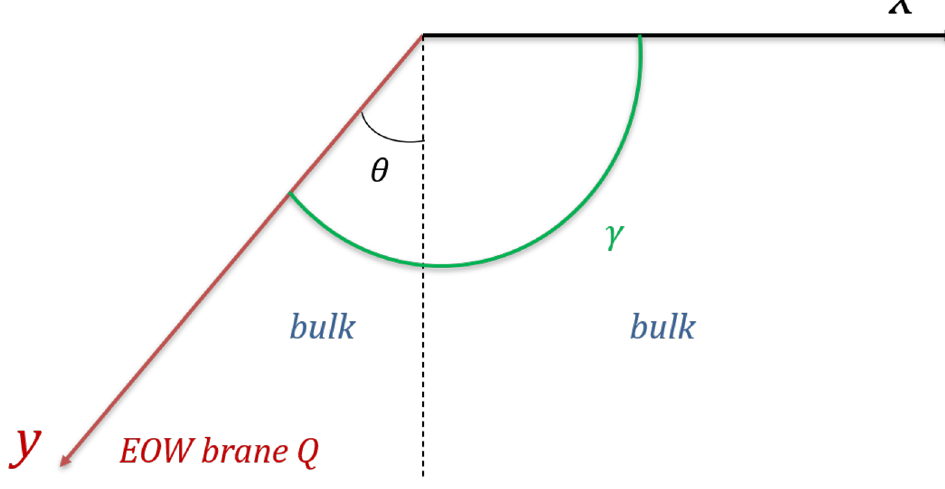
Figure 1 . Holographic dual of a BCFT 2 defined on half space ( x > 0)